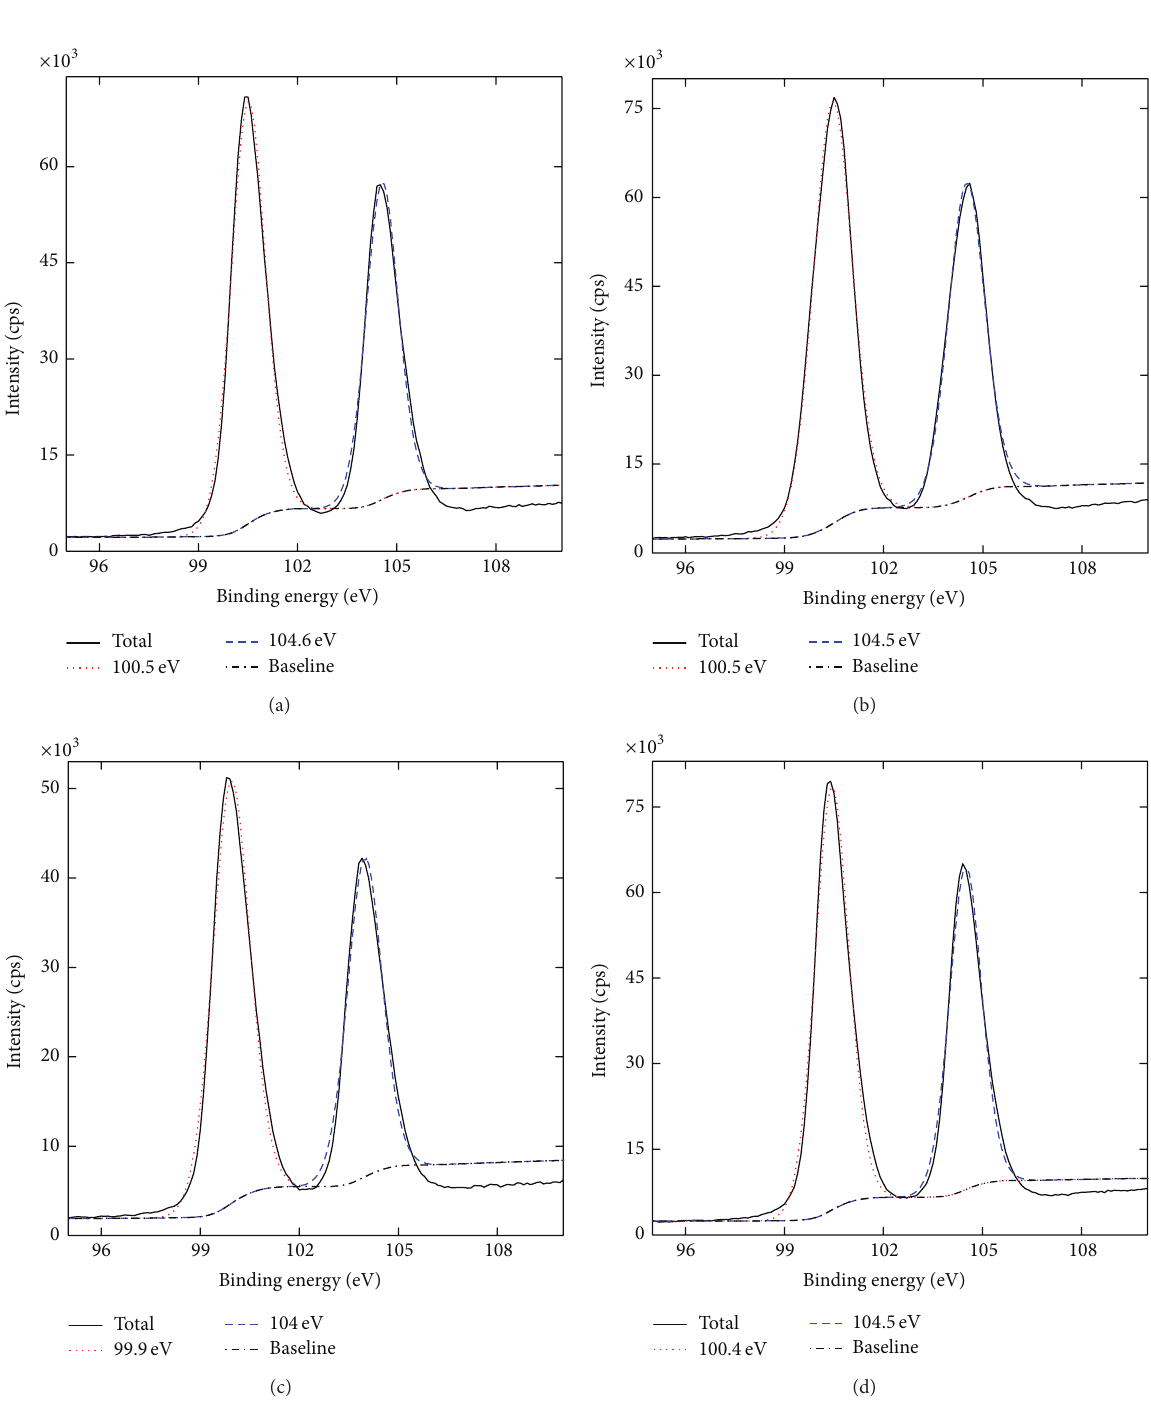
Figure 3: Hg4f spectra of Zuota samples. (a) S1; (b) S2; (c) S3; (d)